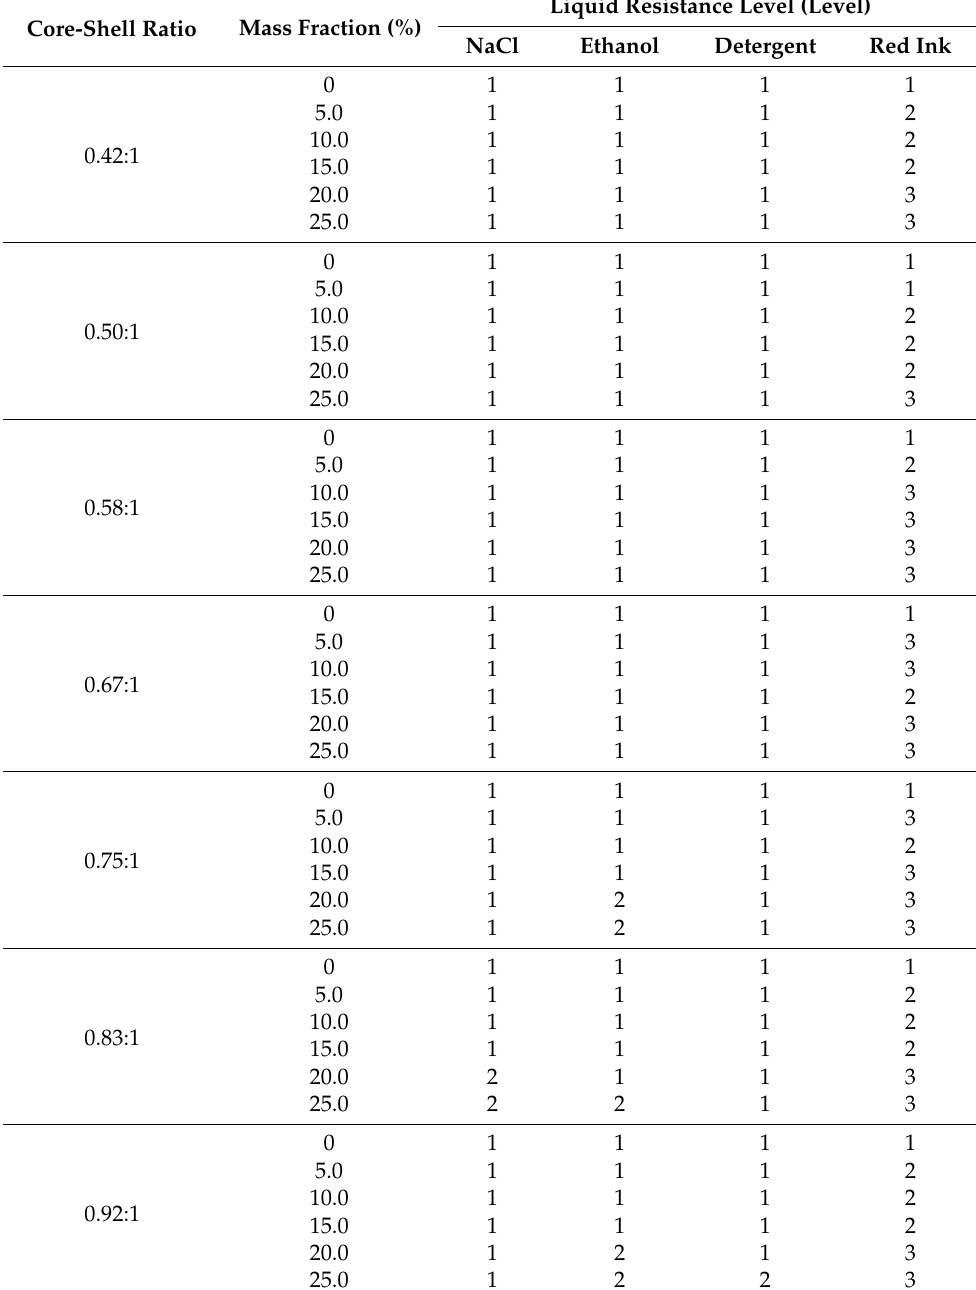
Table 9. Effect of microcapsule concentration and core-shell ratio on liquid resistance level. Core-Shell